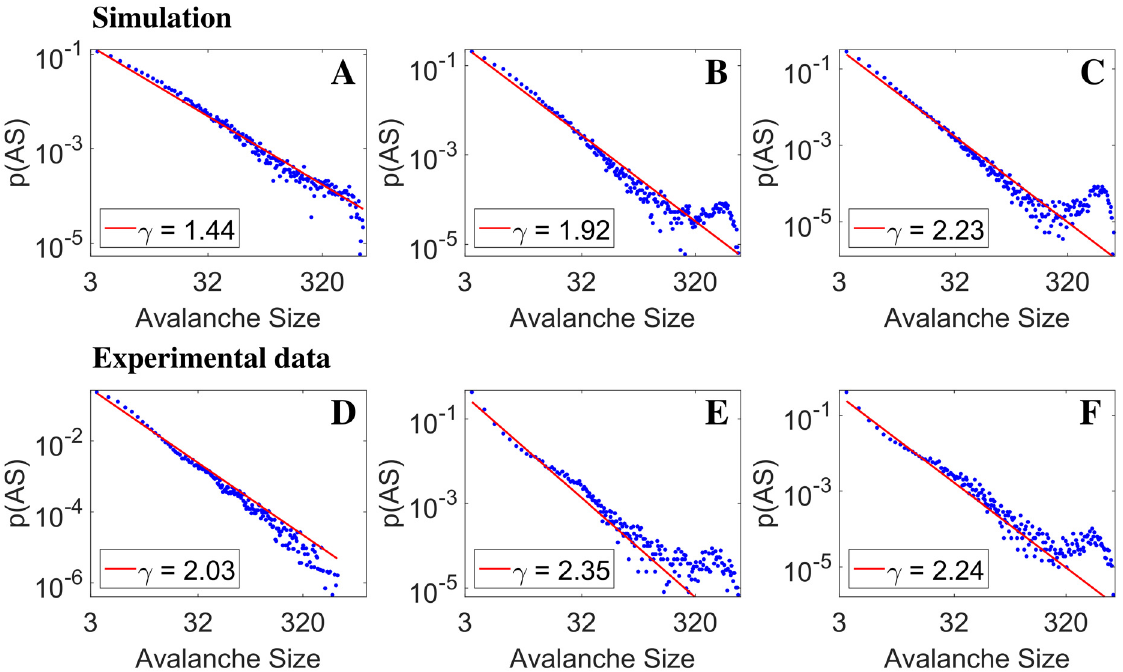
Fig 6. Avalanche size distribution: simulations vs ex-vivo data. Panels A-C: mean-field simulations, with fixed inhibition w inh = 1. and increasing excitation (w exc = 0.9, 0.94, 1). The distributions are well fitted by power-laws; panel B and C clearly show the buildup of ‘ bumps ’ in the high-size tails, reflecting the increasing contribution from network spikes and quasi-orbits in that region of the distribution. Panels D-F from ex-vivo data, different * 40-minute segments from one long recording; power-laws are again observed, although fitted exponents cover a smaller range; in panels E and F , bumps are visible, similar to model findings. The similarity between the theoretical and experimental distributions could reflect changes of excitatory/ inhibitory balance in time in the experimental preparation. Since all the three simulations lay on the left of or just on the bifurcation line (white line in Fig 2), the shown results are compatible with the experimental network operating in a slightly sub-critical regime.